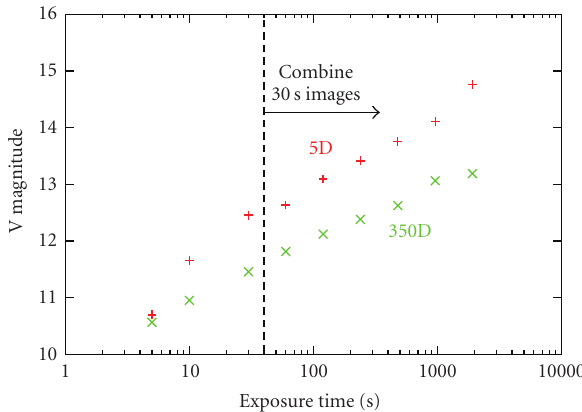
Figure 5: The summary of W band limiting magnitude with 5D and 350D. In the right side of the dashed line, the exposure time becomes long by combining the frames. There is a di ff erence of about one magnitude between 5D and